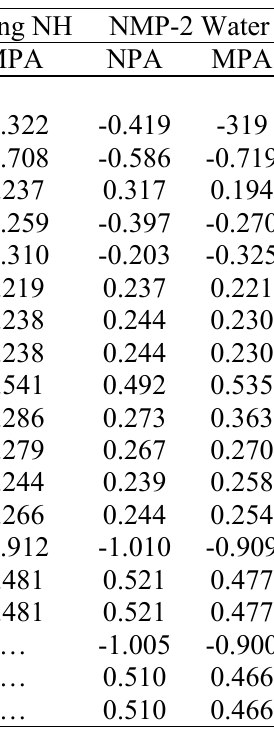
Table 3. Atomic charges of NMP and NMP-water complexes calculated at NPA and MPA schemes.